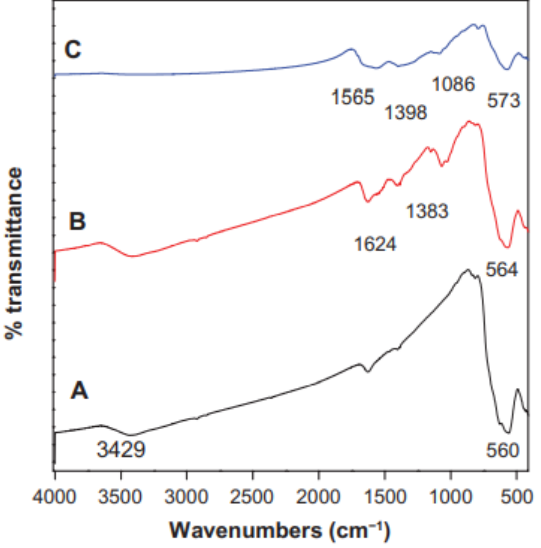
Figure 5. Fourier transform infrared spectra of (A) iron oxide nanoparticles, (B) iron oxide nanopar- ticles coated with chitosan, and (C) iron oxide nanoparticles coated with chitosan and gallic